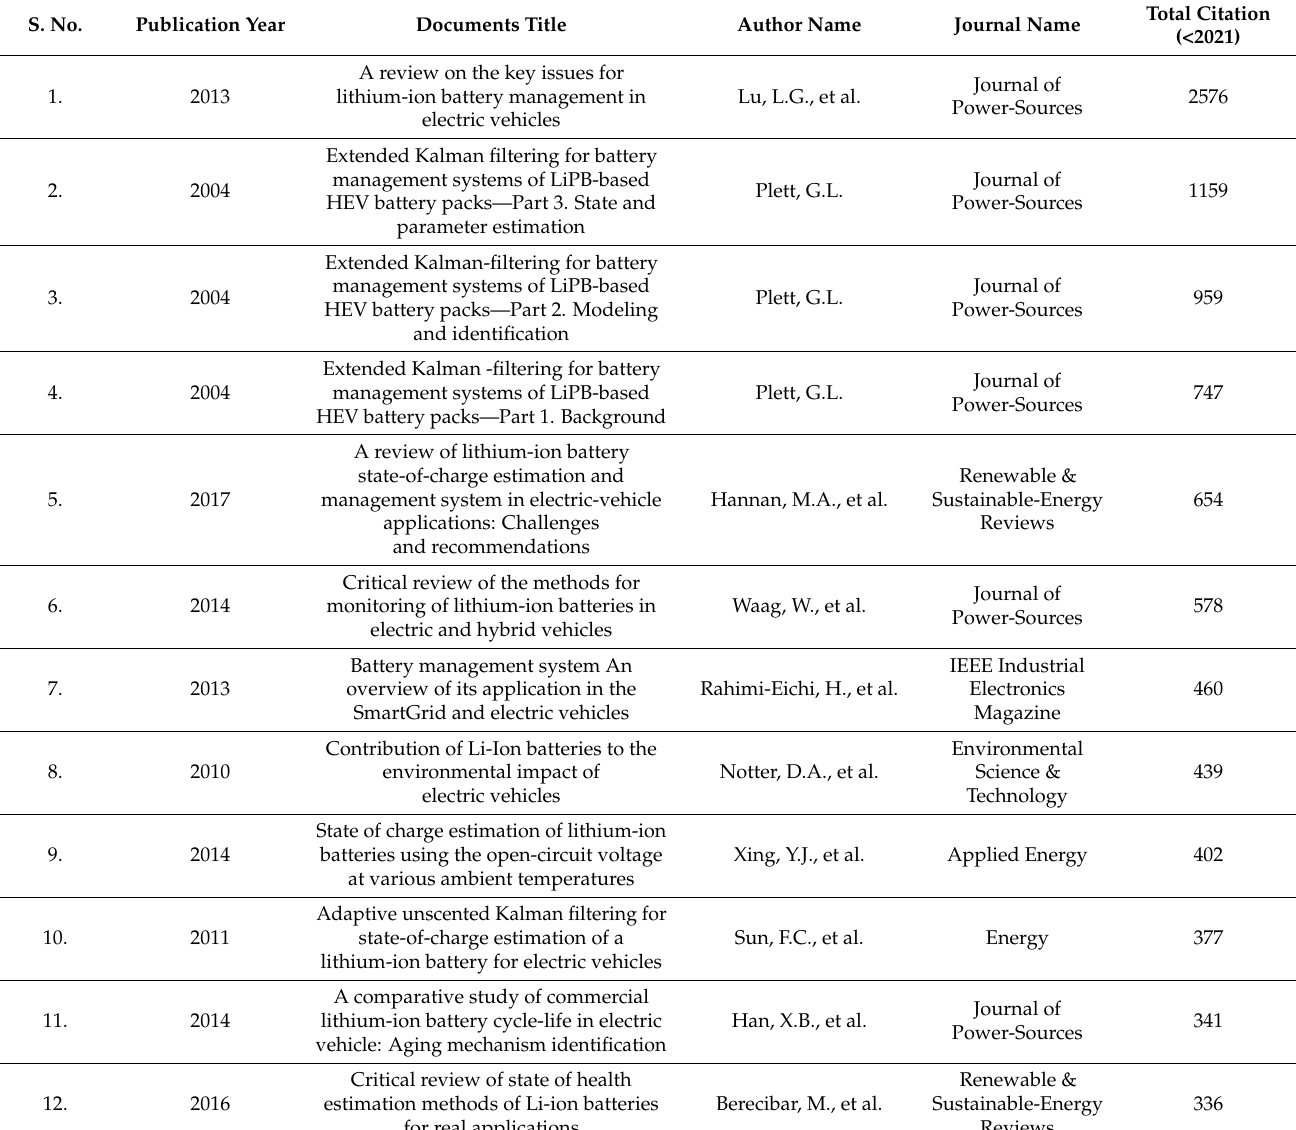
Table 9. Top 15 cited papers in WOS databases for BMS EV state